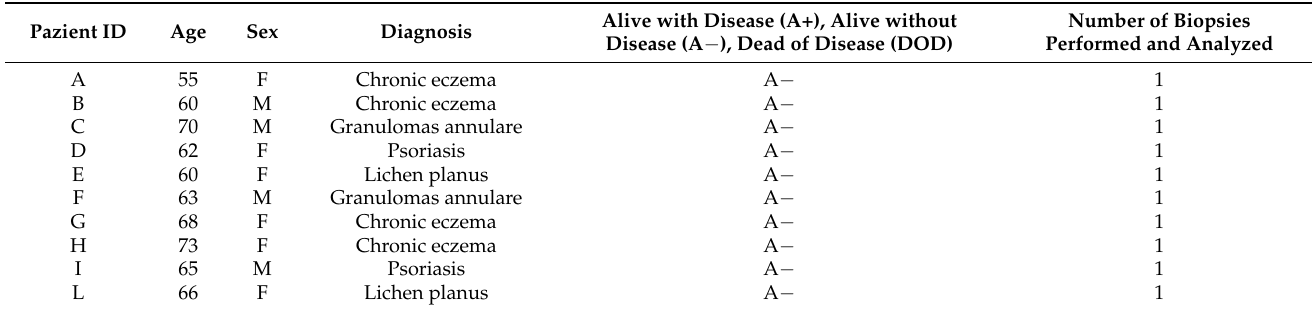
Table 2. Clinical information of controls patients.